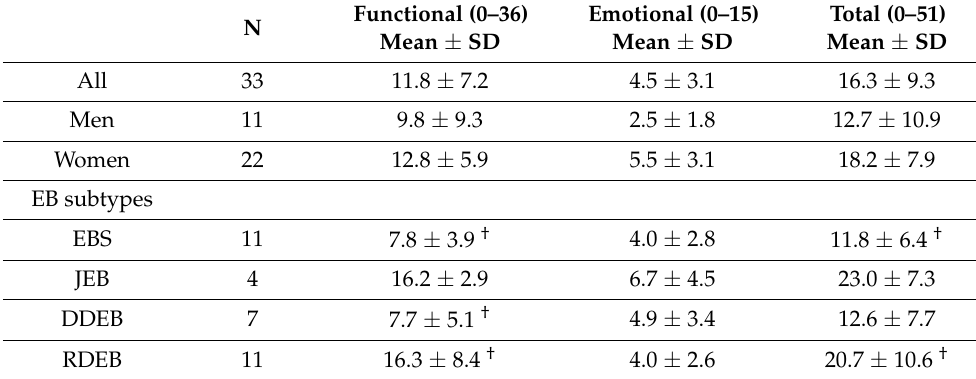
Table 2. Results of the Spanish version of the Quality of Life in Epidermolysis Bullosa (QoLEB) questionnaire by sex and EB subtype.